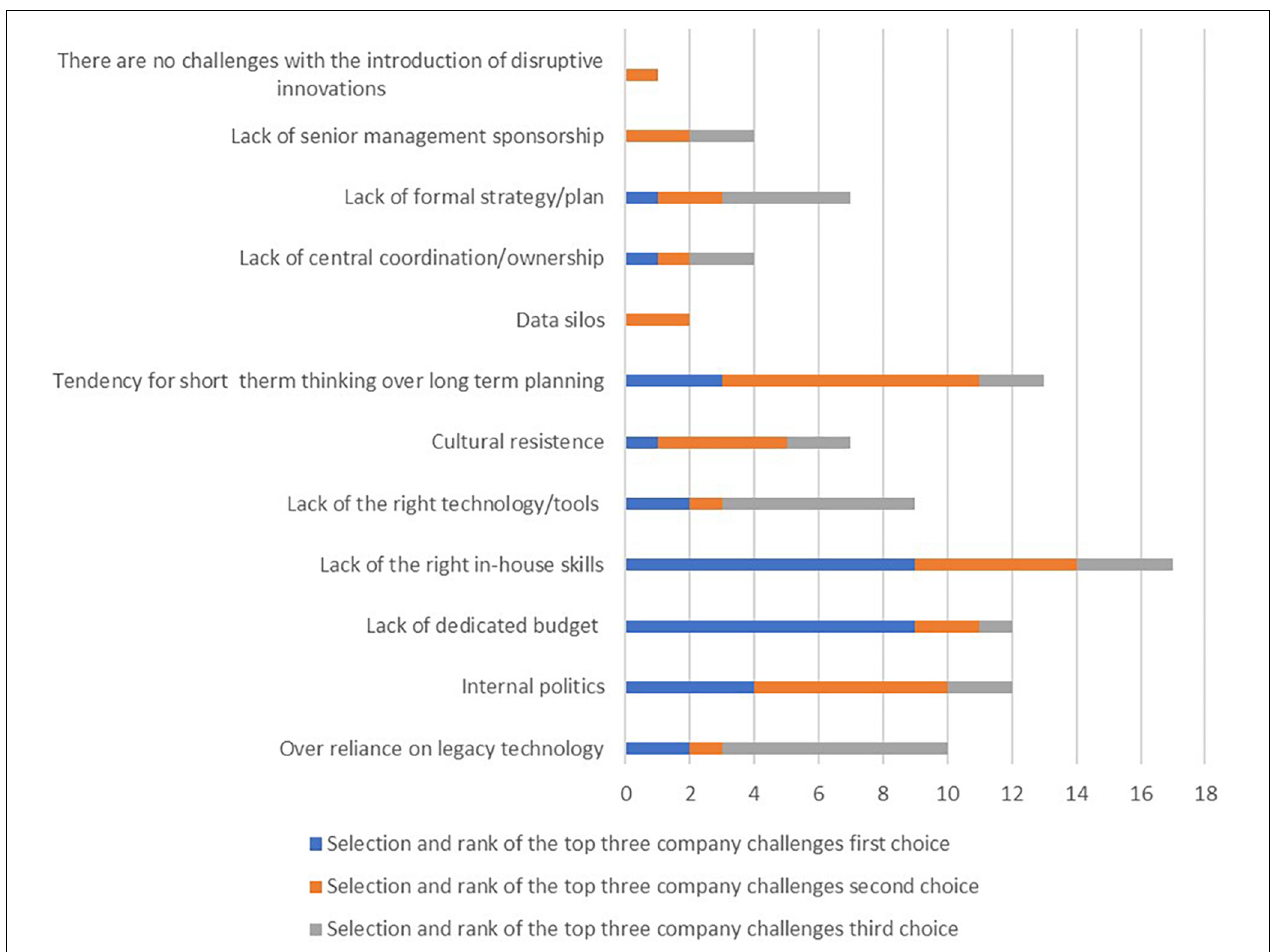
FIGURE 2 | The average rank of the most important organizational challenges ( n = 49; source: